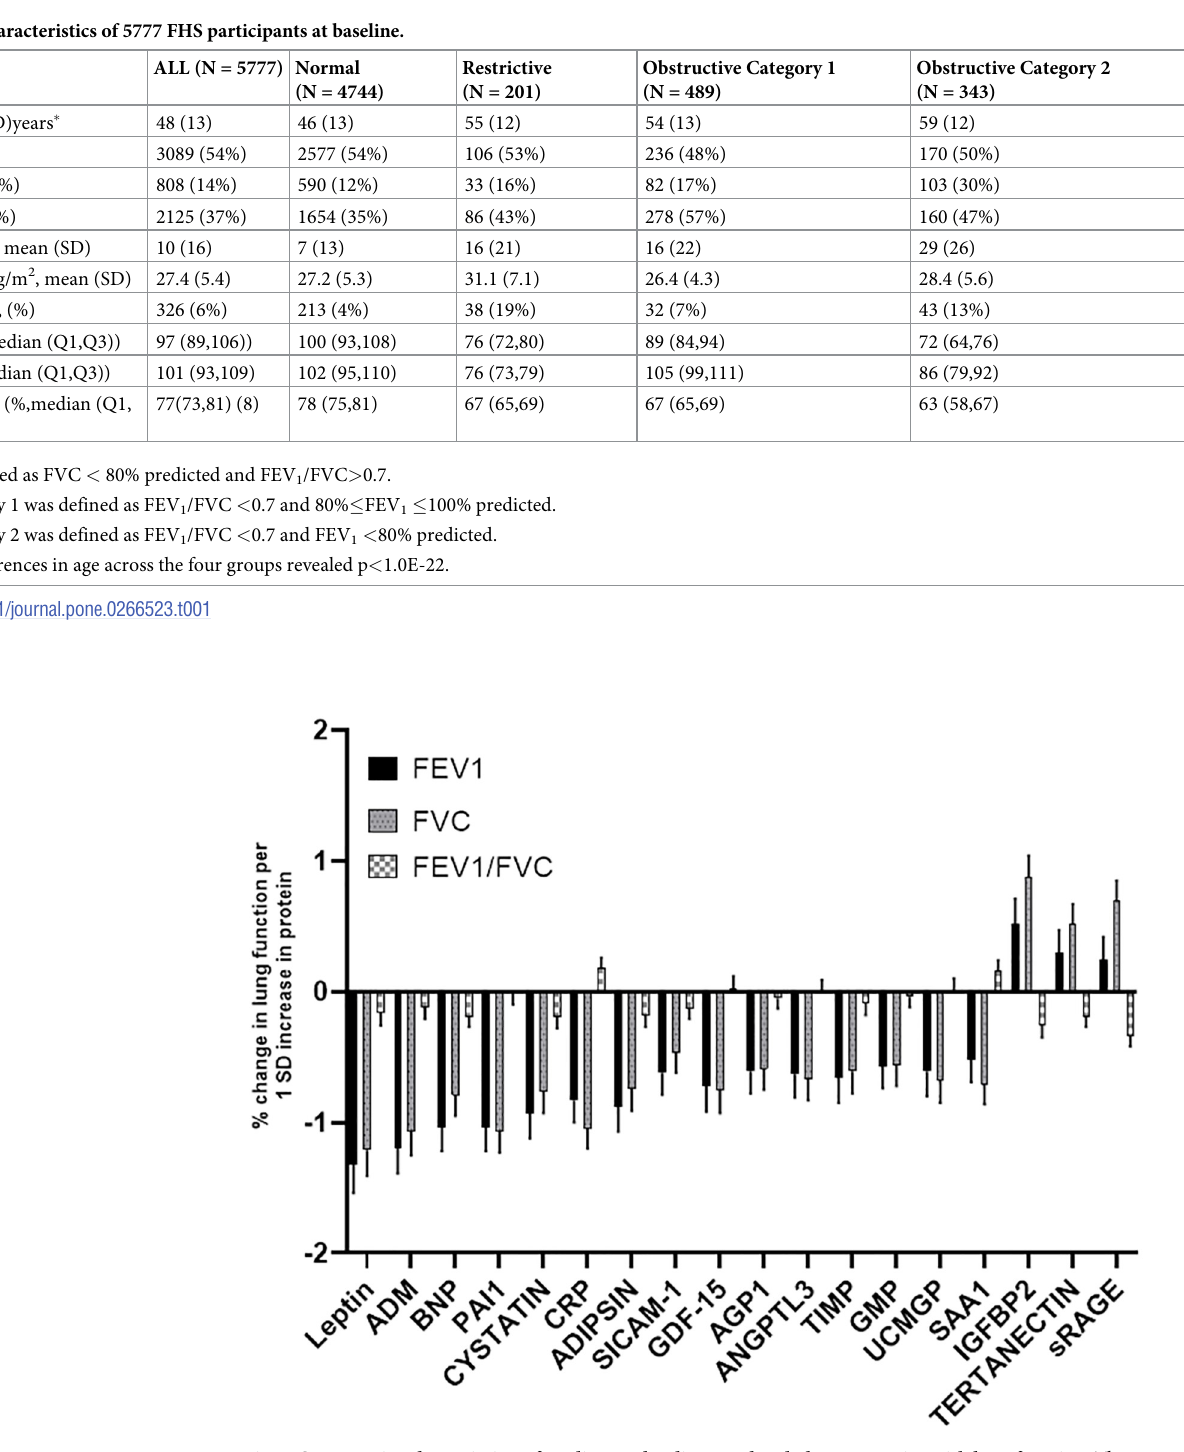
Fig 1. Cross-sectional association of cardiovascular disease related plasma proteins with lung function. There were 18 proteins with associations with baseline FEV 1%predicted , FVC %predicted, or FEV 1 /FVC ratio. Of these proteins, 15 were associated with lower FEV 1%predicted and FVC %predicted , with little effect of FEV 1 /FVC